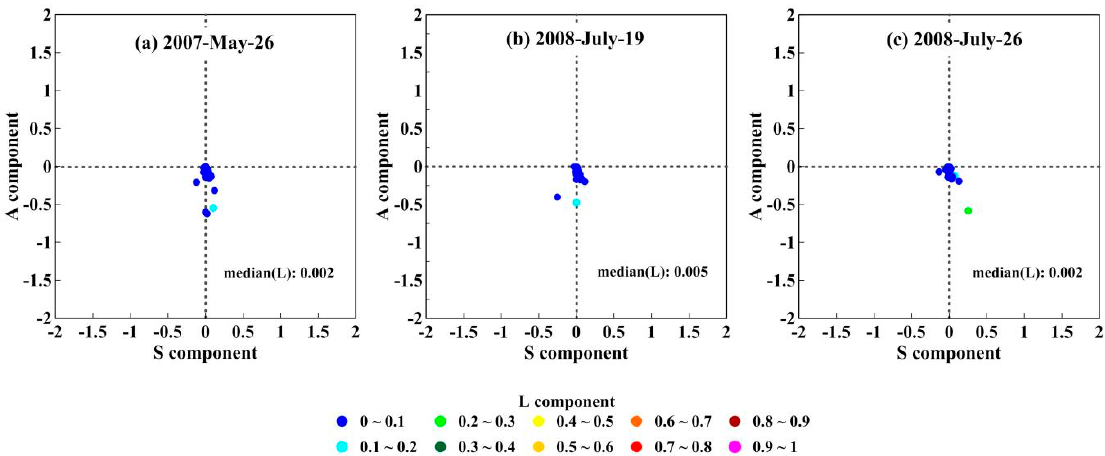
Figure 9. Value distributions of the three structure–amplitude–location (SAL) components. Dashed lines in the vertical and horizontal directions in each sub-figure represent the median values of the S and A components, respectively, and dot color represents the L component value. Results are sorted by selected rain days: ( a ) 26 May 2007; ( b ) 19 July 2008; ( c ) 26 July 2008. Table 4. Results of three geometric index components for sim_ref and obs_ref data sets. Values are sorted at 5, 50, and 75 percentile